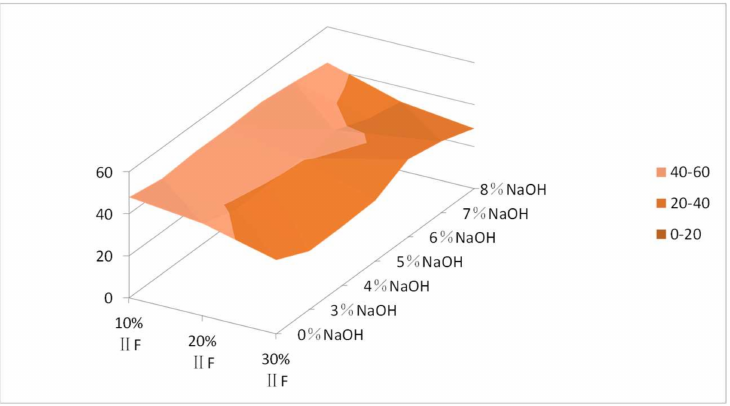
Figure 7. Response surface of compressive strength at 28 days.